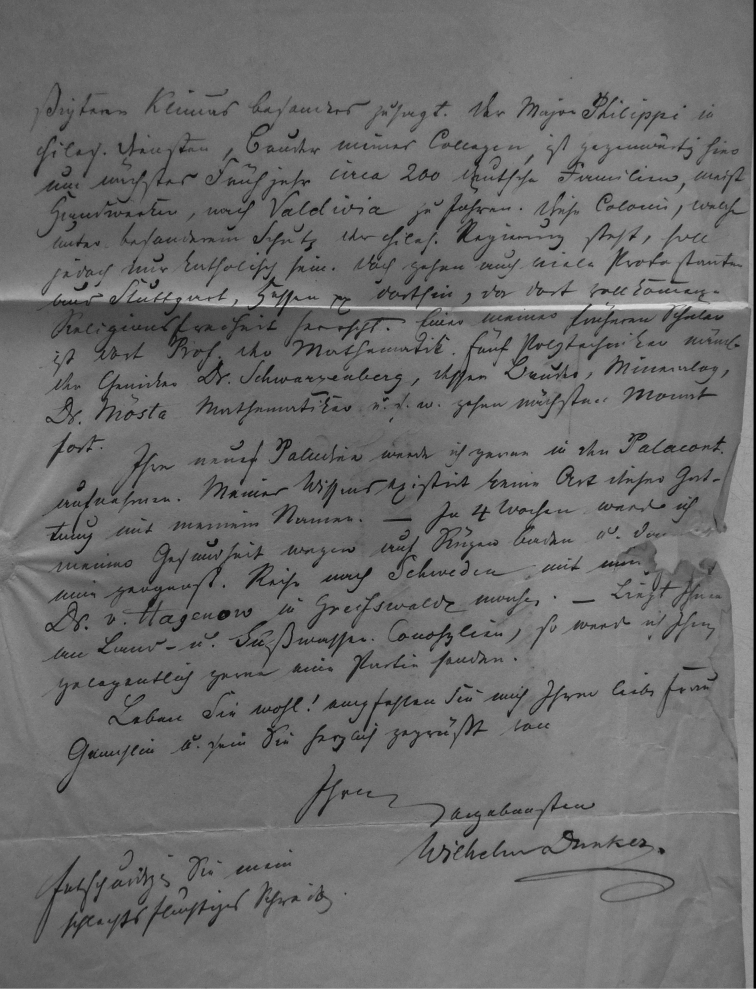
Handwriting of W. Dunker. Excerpt from letter d.d. Cassel, 26.vi.1849 (22 × 27.5 cm).